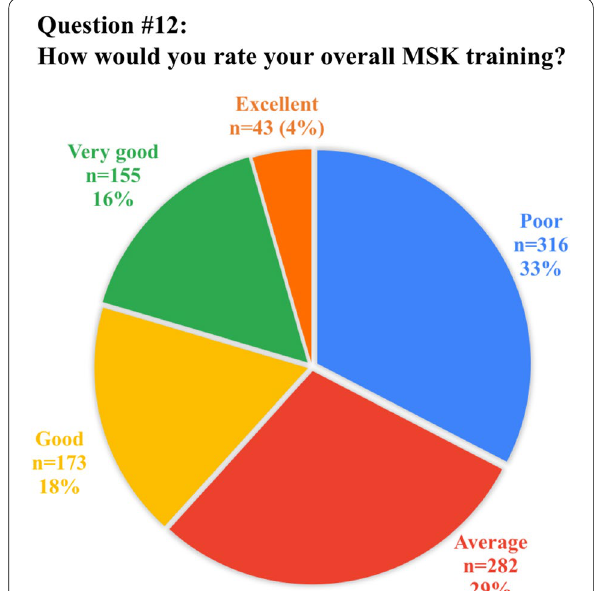
Fig. 3 Graphical representation of answer distribution to question #12: overall rating of MSK training